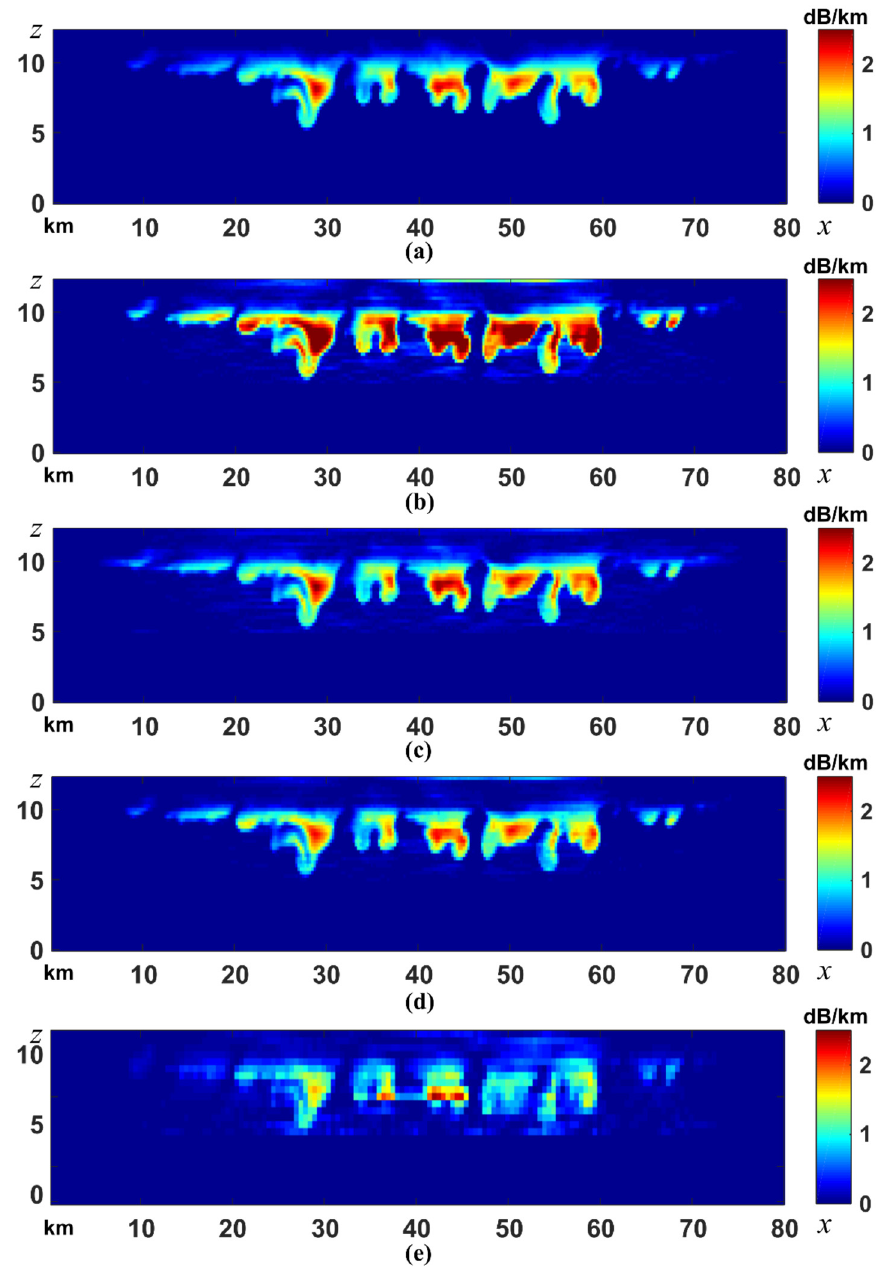
Figure 3. Panel ( a ) is the reference attenuation field. Panel ( b ) shows the retrieved attenuation field after the first least-squares. Panel ( c ) is the retrieved field by averaging the third and fourth iterations of least-squares. Panel ( d ) is produced by processing the result in panel ( b ) using the piecewise linear (PL) function. Panel ( e ) is the retrieved attenuation field with enlarged basis